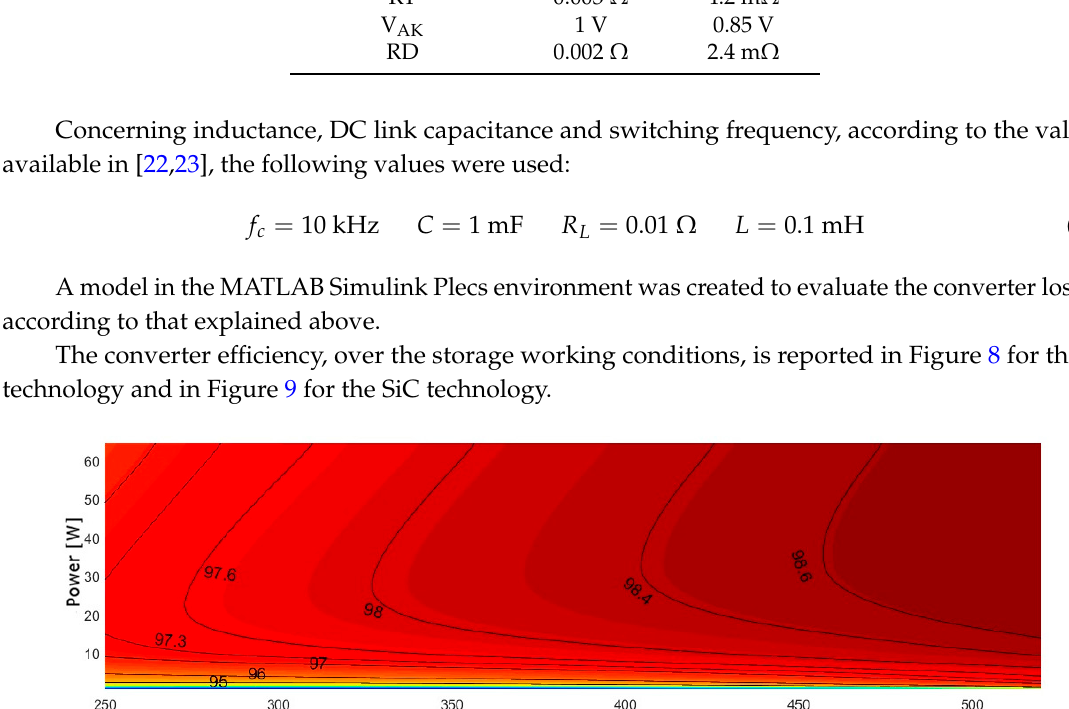
Figure 9. DC-DC SiC converter efficiency [%]. 4. Simulation Results 4.1. Electric Powertrain Efficiency In order to evaluate component efficiency and overall powertrain efficiency in different working conditions, a MATLAB Simulink model was created (Figure 10).